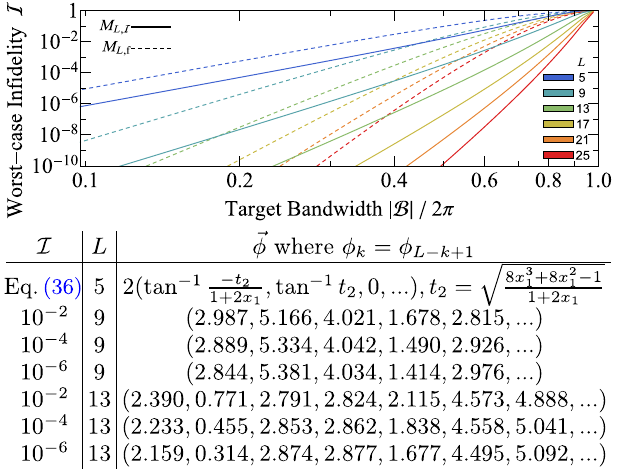
FIG. 2. Worst-case infidelity I of NOT gates OB n ¼ ½ · ; 0 ; M 2 n ð sin ð θ = 2 ÞÞ ; · (cid:2) [solid line; Eq. (37)] optimized for þ 1 ; I target bandwidth θ ∈ B compared to the flatness-optimized NOT ( sin ð θ = 2 Þ ) ; · (cid:2) [dashed line; Eq. (35)], gate BB n ¼ ½ · ; 0 ; M 2 n þ 1 ; f plotted for L ¼ 2 n þ 1 ¼ 5 ; 9 ; … ; 25 (from top to bottom). Observe that I for OB n is exponentially smaller by a factor ≈ 4 n than BB n . Alternatively, an OB n gate can approximate NOT with infidelity of, at most, I over a much wider bandwidth than BB n . The table provides examples of ~ ϕ for OB n rounded to three decimal